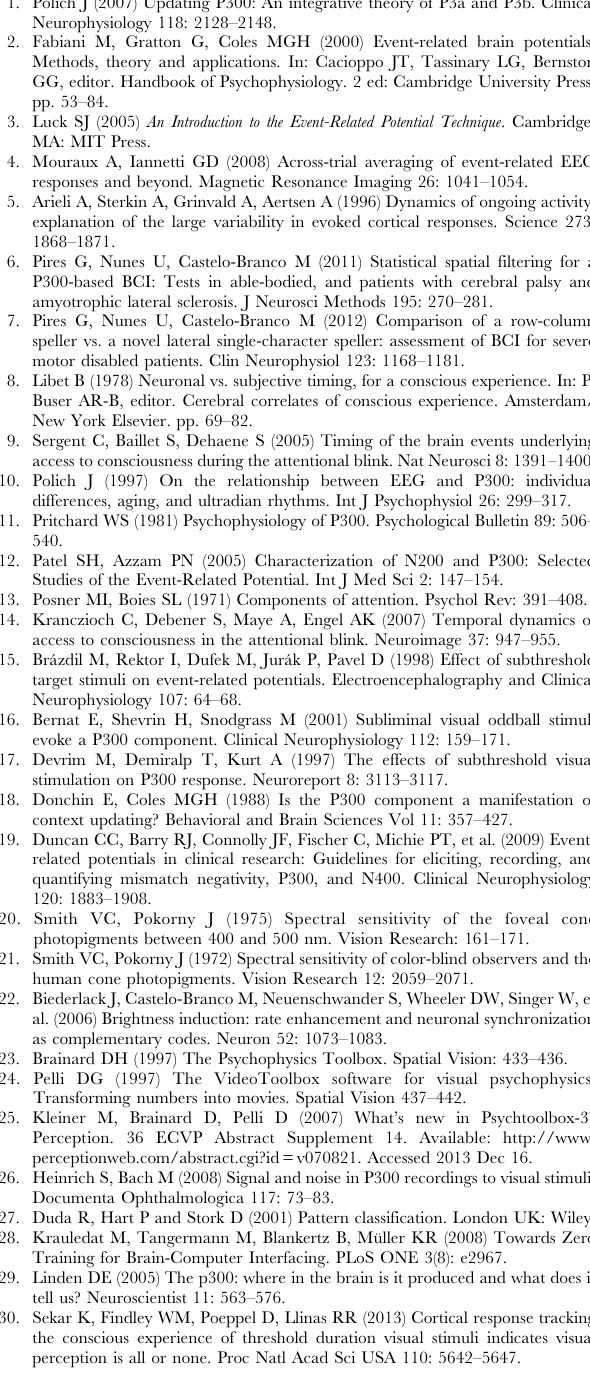
Session II. Table S7, Individual guessing rates and one sample binomial tests to S + binary detection